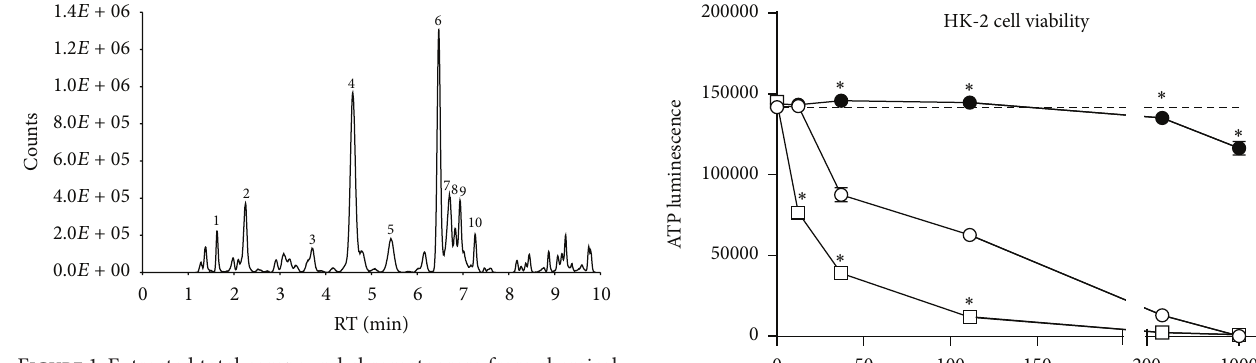
Figure 1: Extracted total compound chromatogram from chemical characterization of the C. zacatechichi extract by LC-high resolution mass spectroscopy. Putative compound identification was made by matching exact mass with that of known components of C. Figure 2: C. zacatechichi significantly decreases cell viability in a